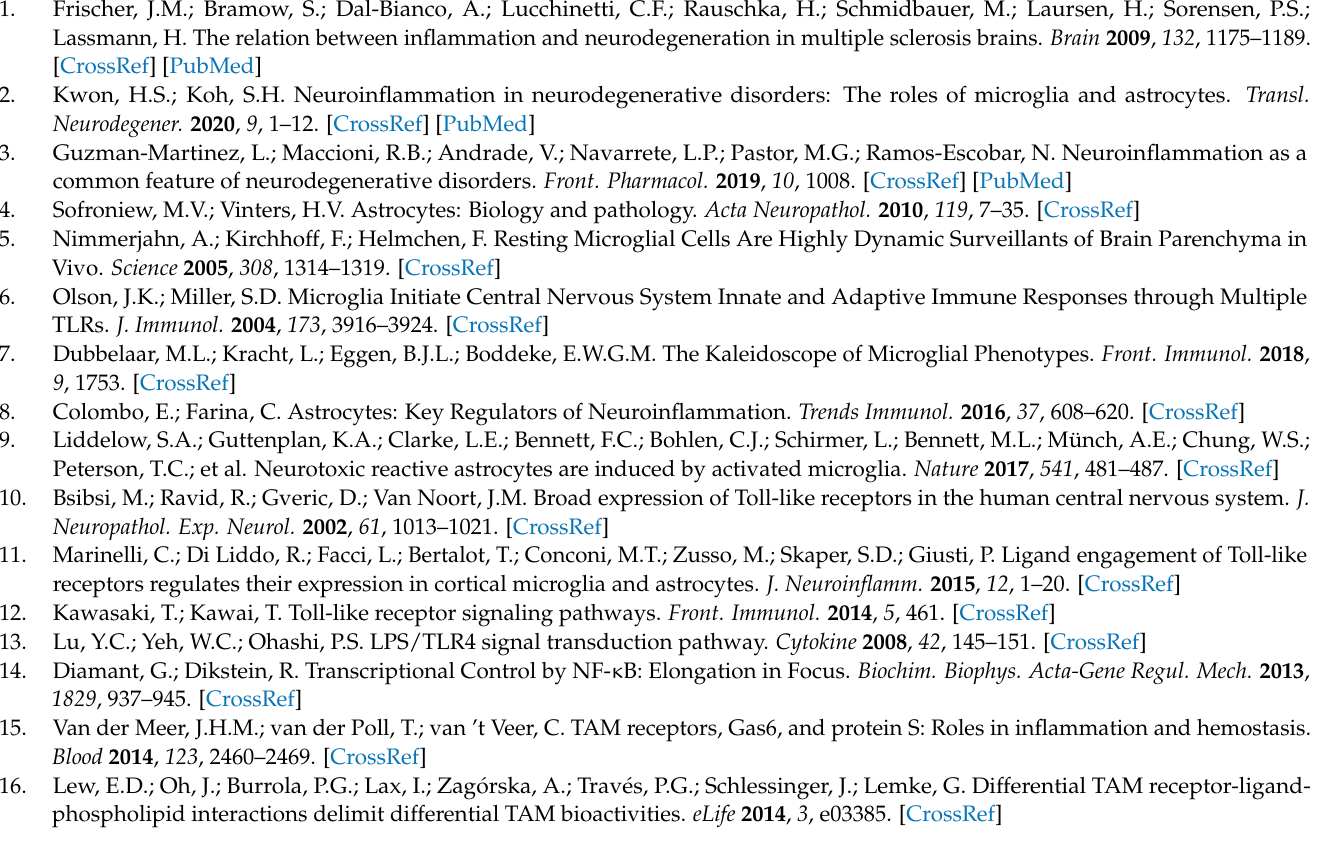
primers, Figure S1: Workflow for image analysis of nuclear translocation images, Figure S2: Gas6 treatment alone did not alter the baseline Csf2 expression levels in microglia, Figure S3: Inactivated Gas6 (wGas6) is not effective in reducing Csf2, Figure S4: Mixed glial cultures contain 10–15% of to